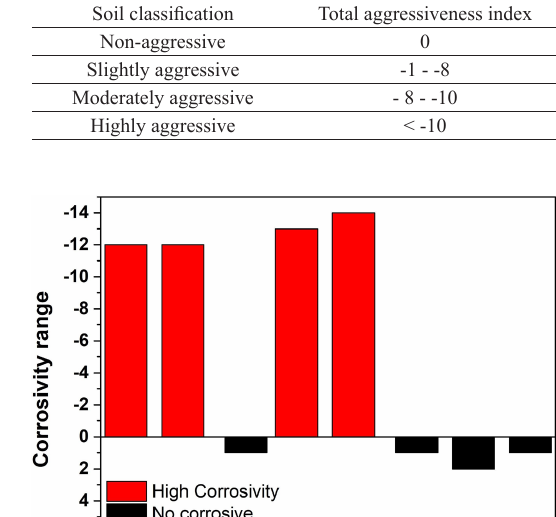
Table 9. Criteria for soil aggressiveness.